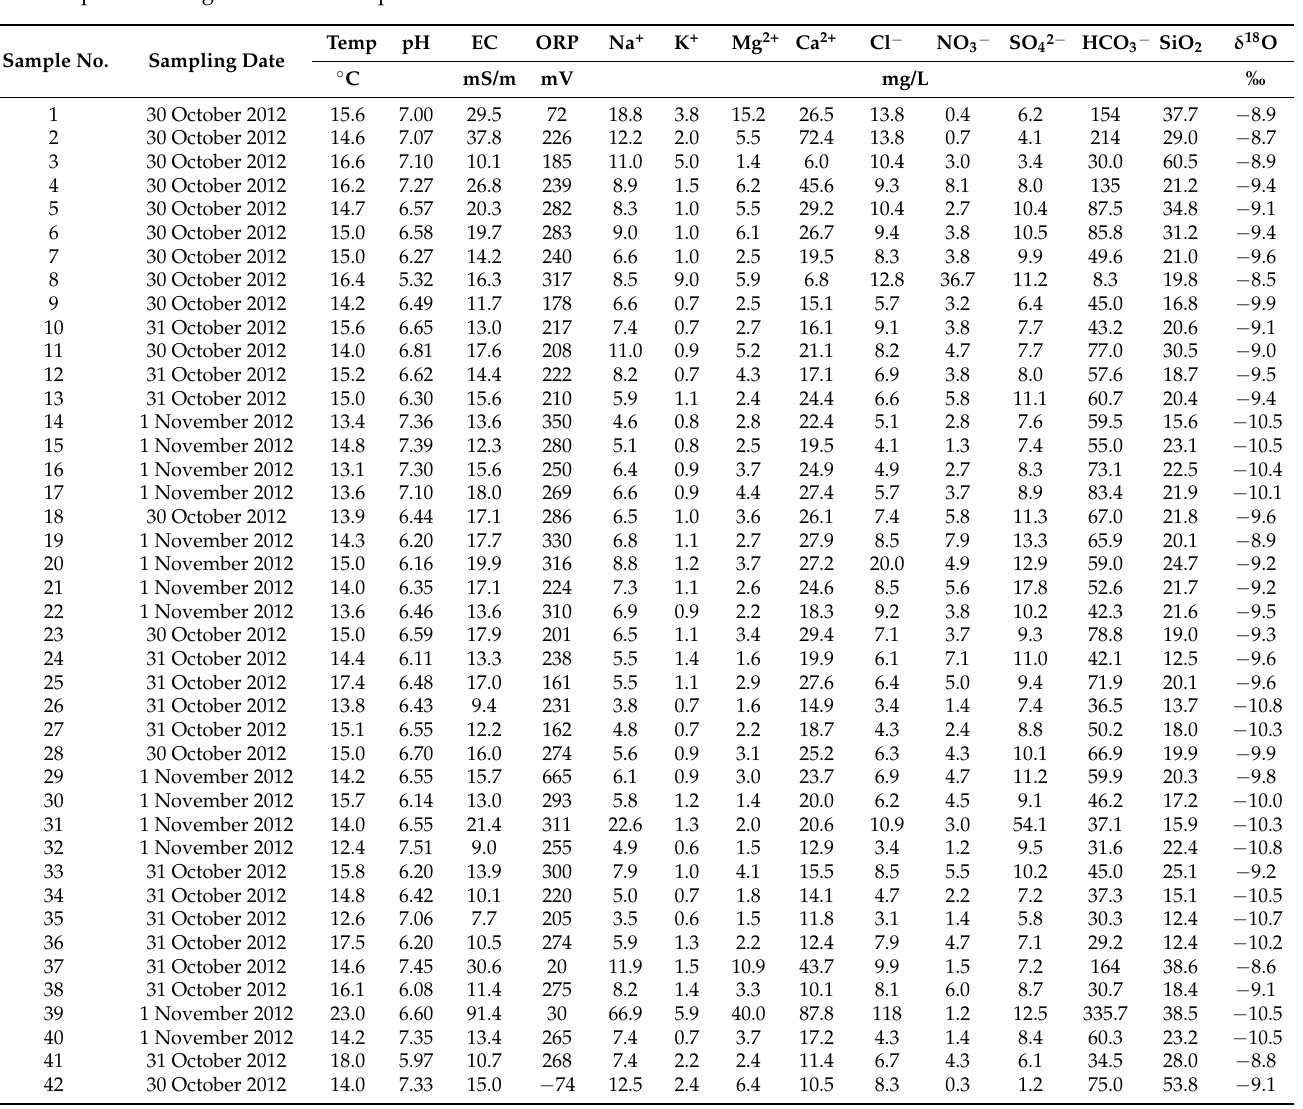
Table 9. Water temperature, pH, electric conductivity (EC), oxidation–reduction potential (ORP), chemical, and δ 18 O composition for groundwater samples in the Sho River alluvial fan on 30 October to 1 November 2012. Sample